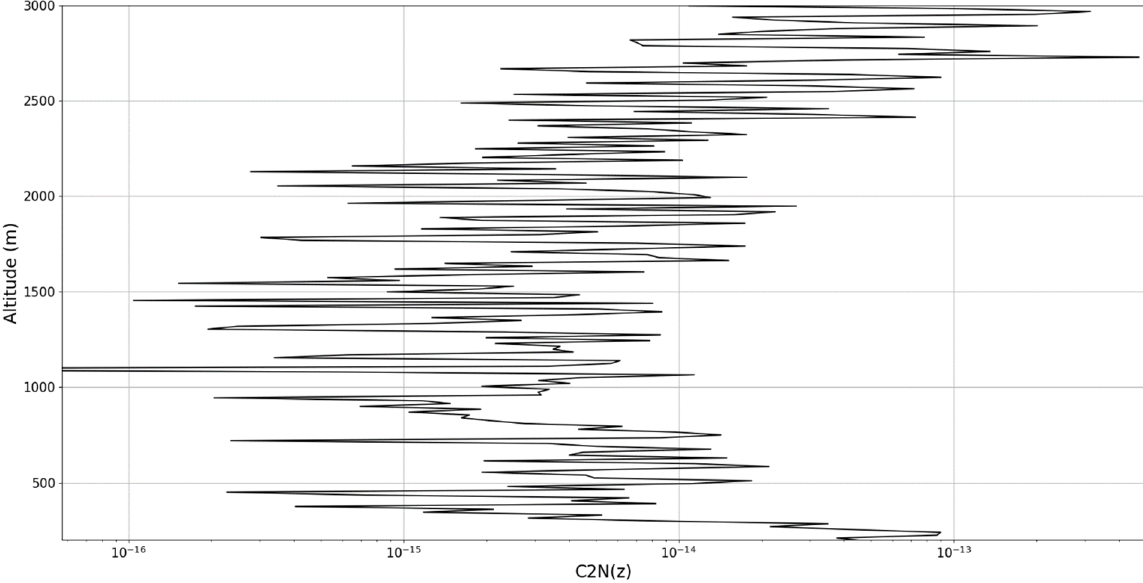
Figure 14. Zoomed-in C (cid:2898)(cid:2870) profile, λ = 1064 nm , Gala ț i, Romania, 22 December 2021.